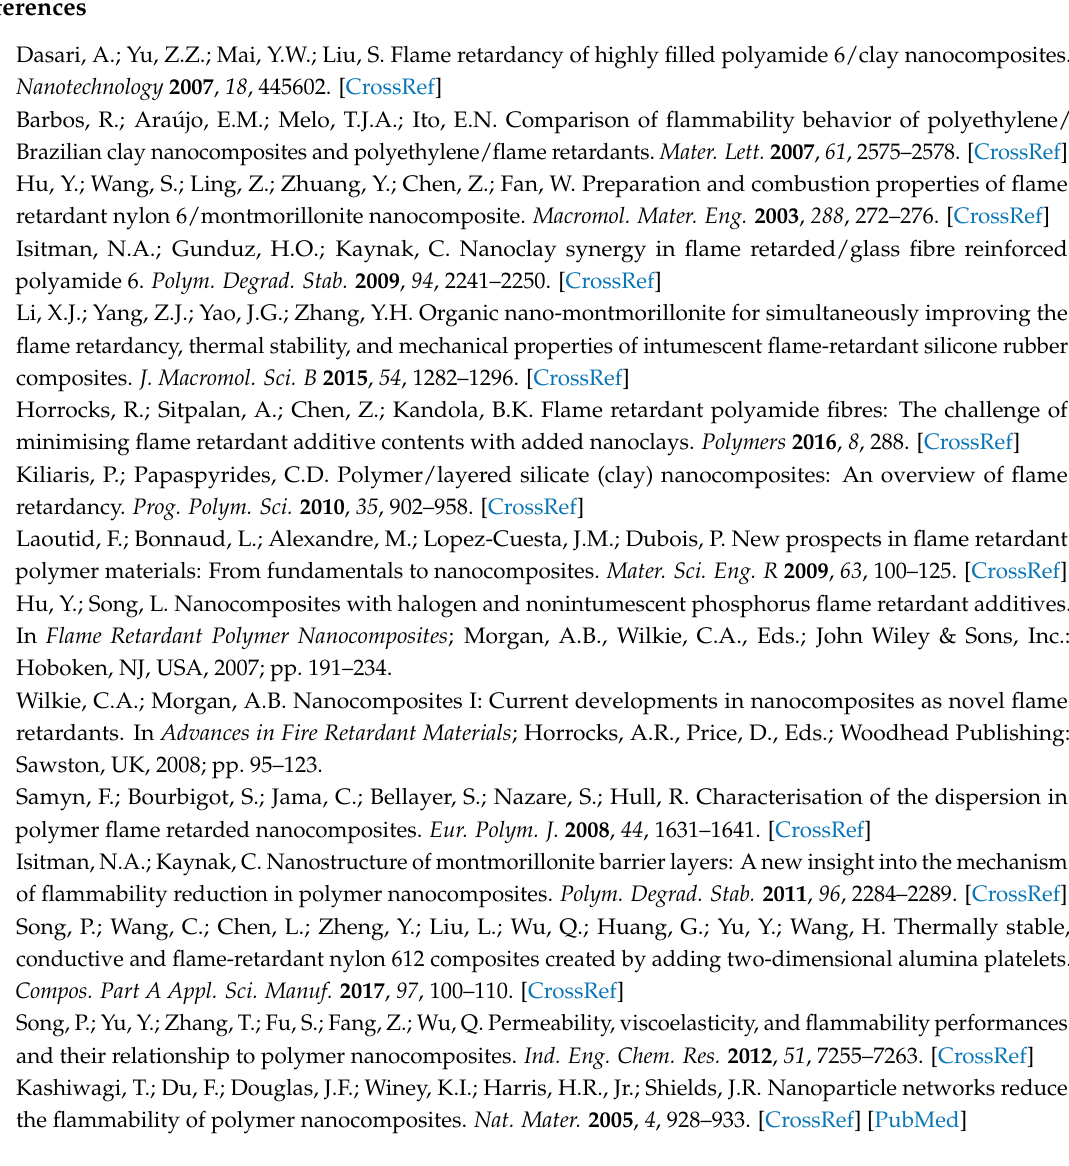
Table S1: UL-94 and LOI data of flame retardant PA6